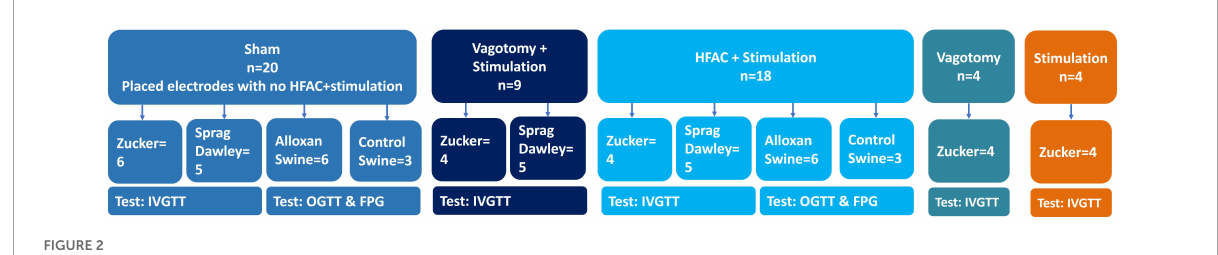
FIGURE2 Depiction of experimental groups and animal numbers/experimental condition.